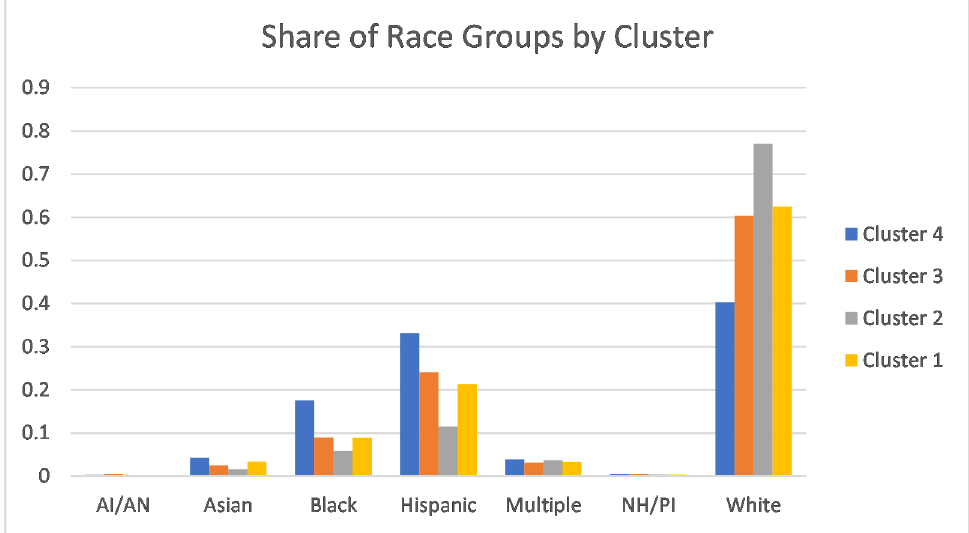
Figure 13. Proportion of individuals for each race group allocated to clusters. Given as a percentage. Cluster 4 was the high-mortality